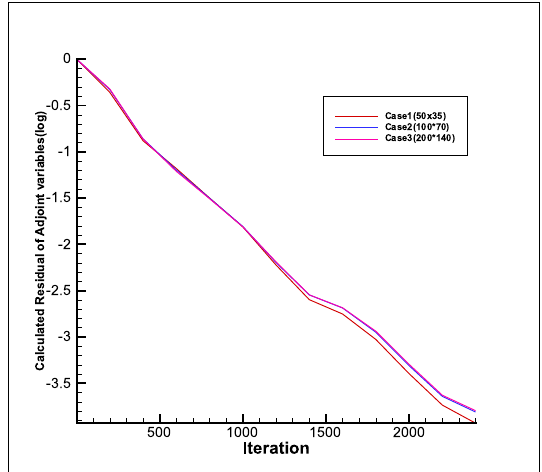
Figure 4. The residual of adjoint variables was calculated for three different mesh conditions using the same input data as the example presented in the Multipurpose Optimization section. A single loop consisting of 2400 iterations was used for the